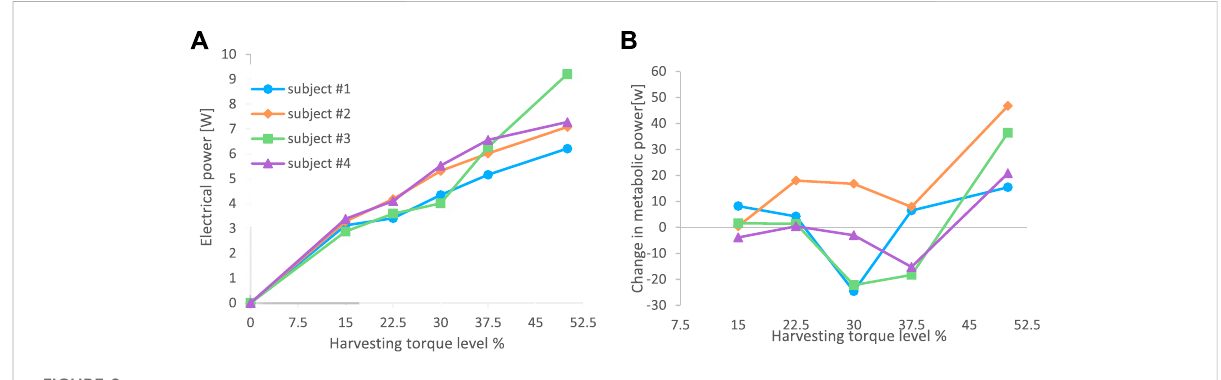
FIGURE 8 Results from the experiments on four subjects. (A) Electrical power output of the system for each of the subjects at six harvesting levels. (B) Metabolic change relative to walking with the device disconnected (dead weight). The fi gure data is in Appendix D.